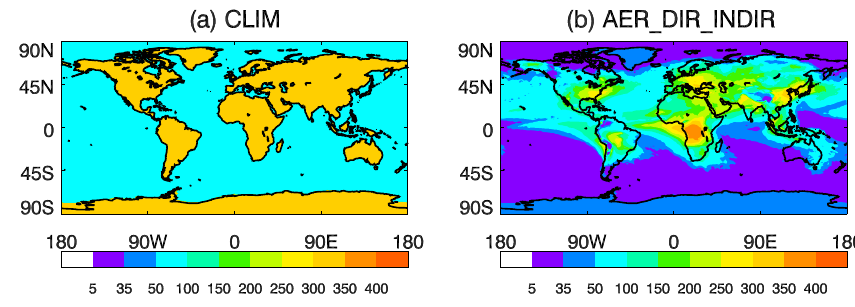
Fig. 10. Potential cloud droplet number concentration at T + 120 from (a) CLIM and (b) AER_DIR_INDIR. Table 2. The global mean day 5 all-sky net radiative forcings (Wm − 2 ) from the different aerosol